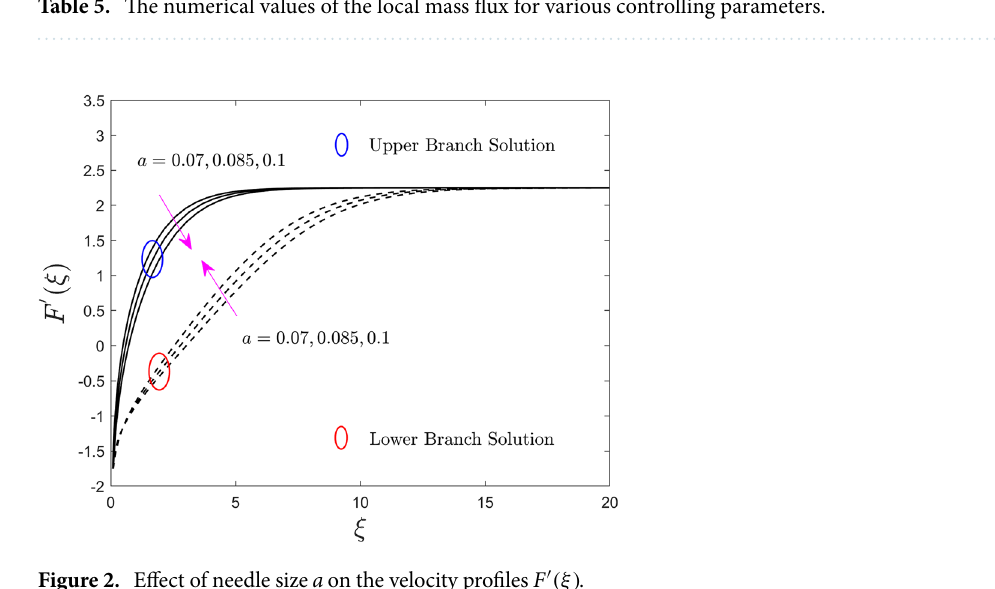
Figure 2. Effect of needle size a on the velocity profiles F ′ (ξ) .